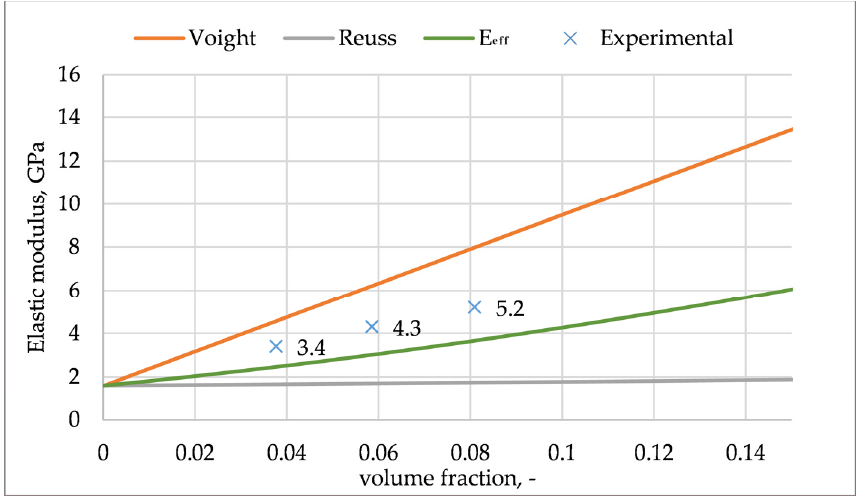
Figure 8. Comparison of modulus experimental results with Voight, Reuss method and method proposed by Wi´sniewska (E eff